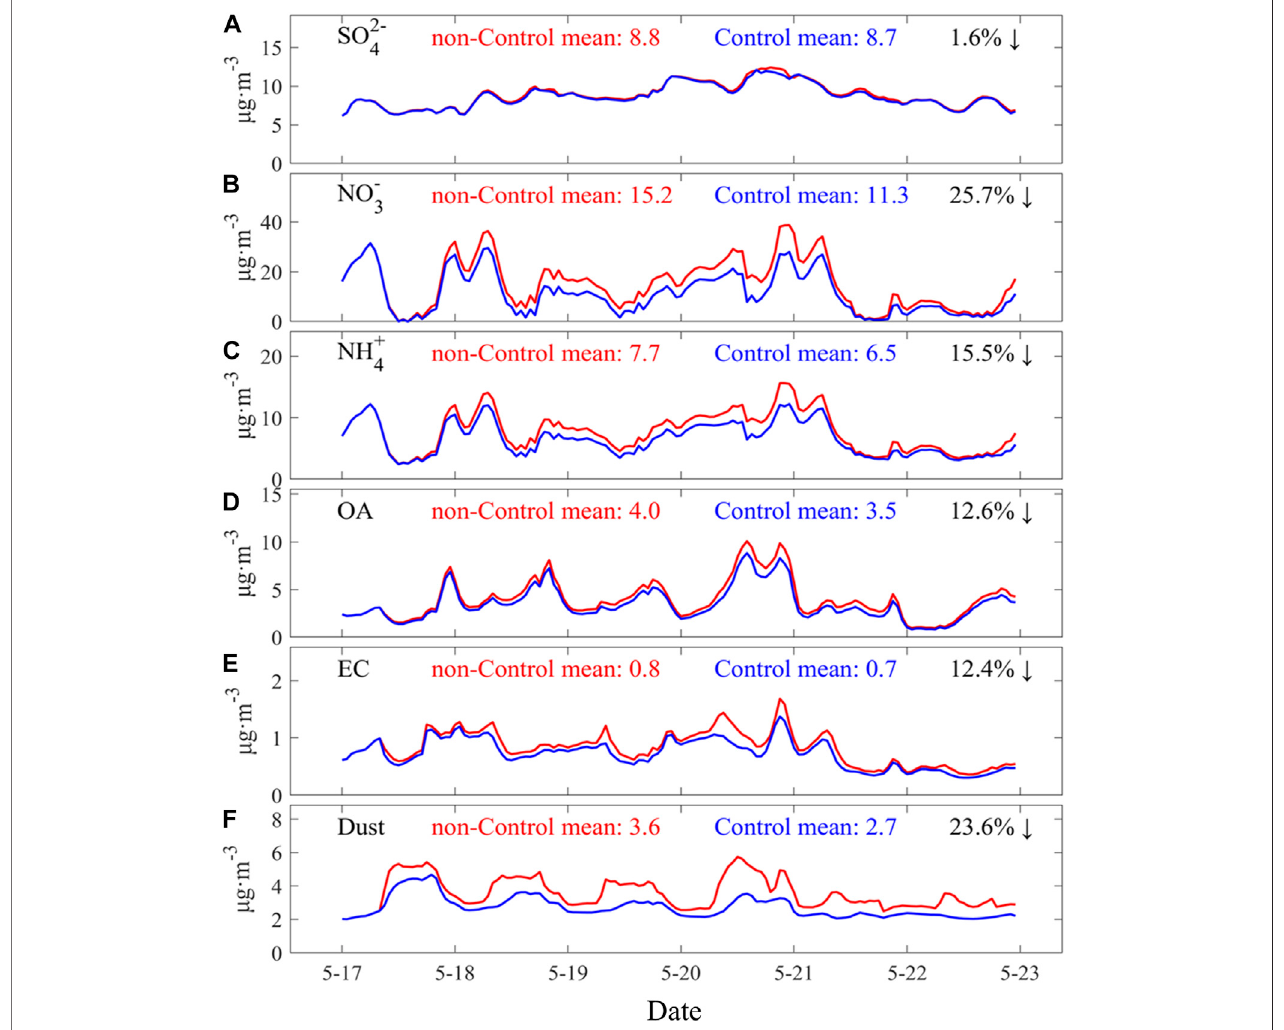
FIGURE 5 | The same as Figure 4 , but for acrosal compositions (A) SO 42 − , (B) NO 3 − , (C) NH 4+ , (D) OA, (E) EC and (F) Dust.